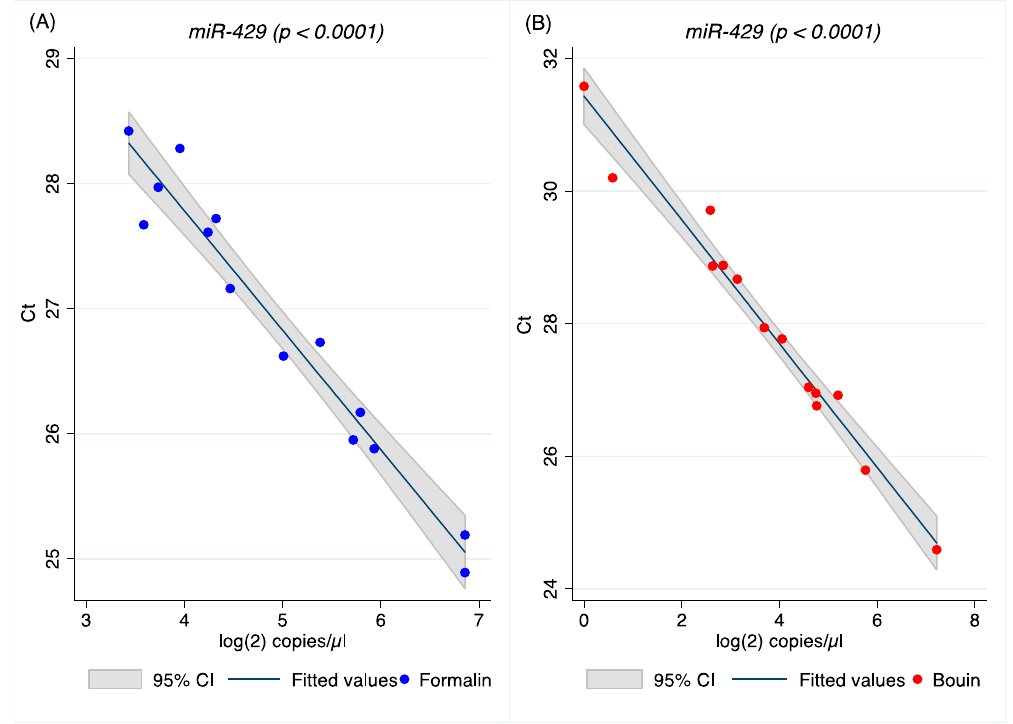
Figure A4. Scatter plot and linear prediction with 95% confidence interval of real-time and ddPCR results for miR-155-5p and miR-200a-3p in formalin- ( A , B ) and Bouin’s-fixed tissues ( C , D ), respectively.